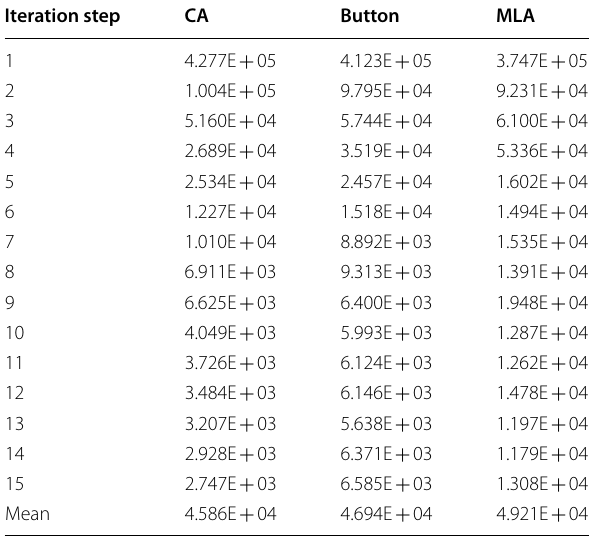
Table 4 Maximum von Mises stress of PDL in M2 for each